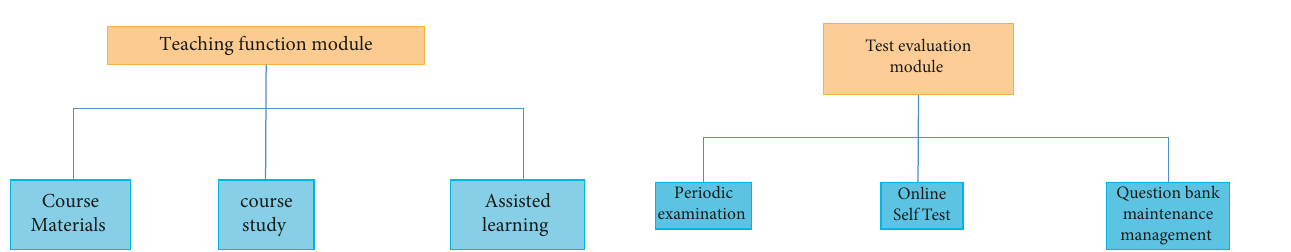
Figure 3: Schematic diagram of teaching function module.